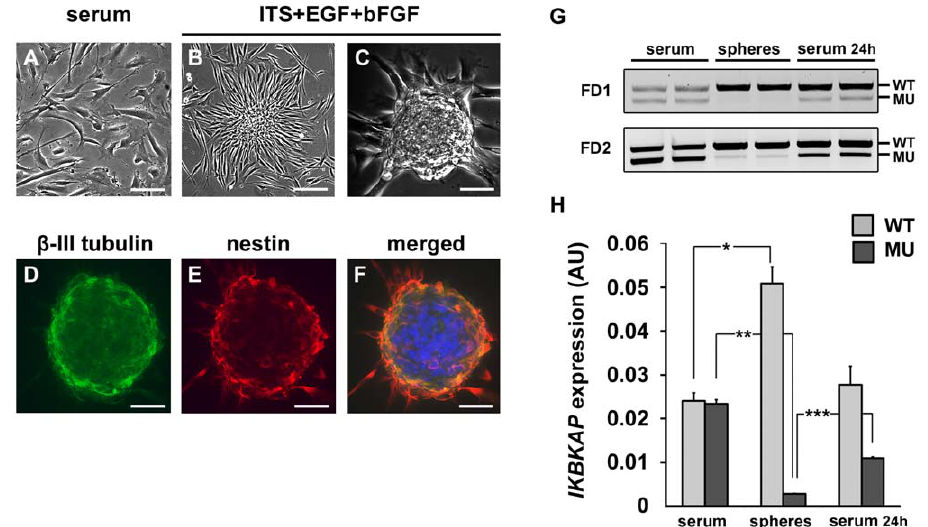
Figure 8. WT:MU ratio is increased in hOE-MSC-derived spheres. FD hOE-MSCs cultured in serum (A) gave rise to spheres when plated in medium supplemented with ITS and growth factors (B and C). Immunostaining showed b -III tubulin and nestin positive spheres (D, E, F). RNA was isolated from 2 different FD hOE-MSCs cultured first in serum, then induced to form spheres, and finally dissociated and replated in serum conditions for 24h (G). RT-qPCR was performed on the same samples and histograms represent the mean value of the two FD samples after normalization with ABL1 gene (H). Scale bars represent 100 m m. (* P , 0,05, ** P , 0,01 using two-tailed Student’s test).